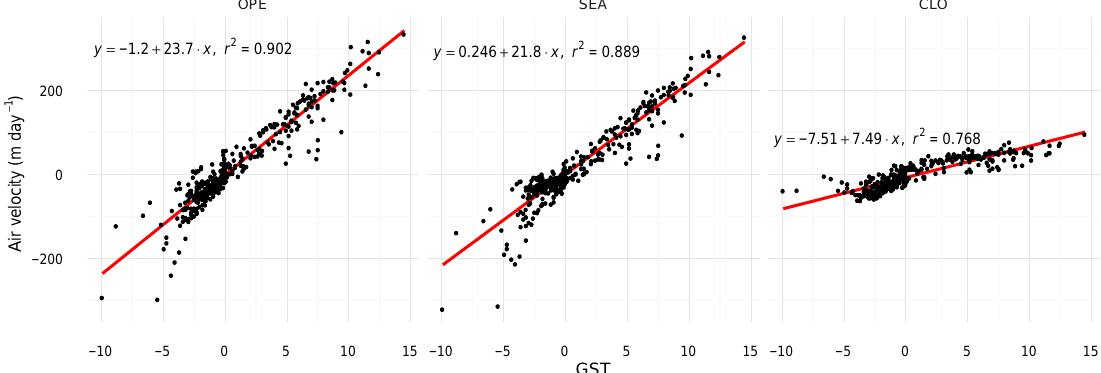
Figure 7. Relation between velocity of the air flow at node B (see Fig. 2) and the forcing ground surface temperature (GST) for the three dif- ferent experiments OPE, SEA and CLO. Positive velocities indicate downslope movement and negative velocities indicate upslope movement of air.